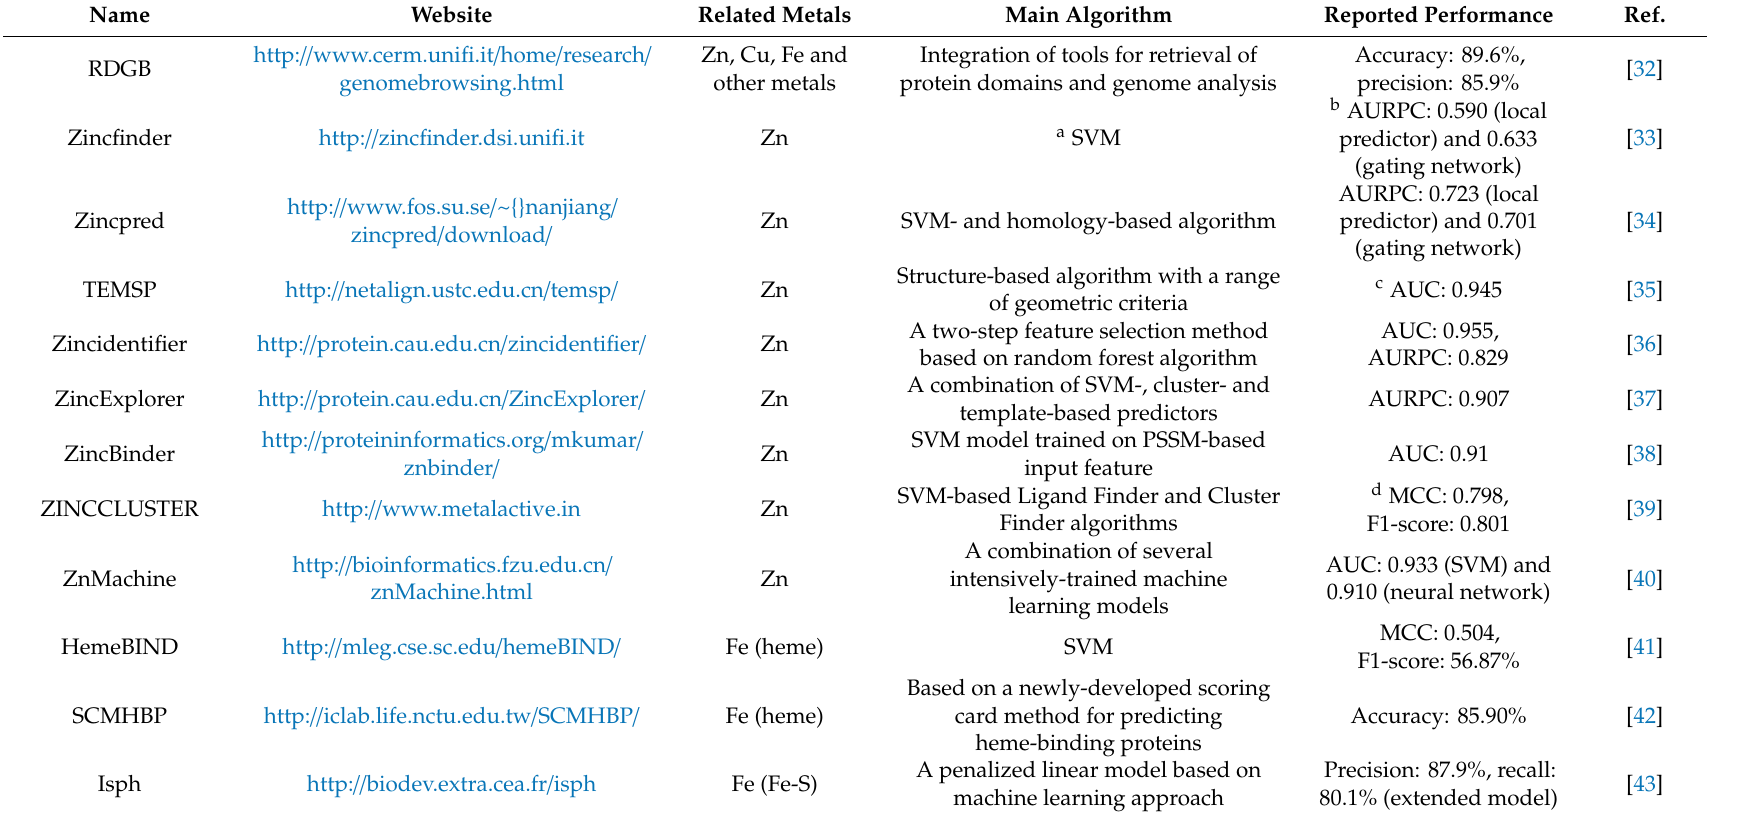
Table 1. Computational tools for metal-binding site and metalloprotein